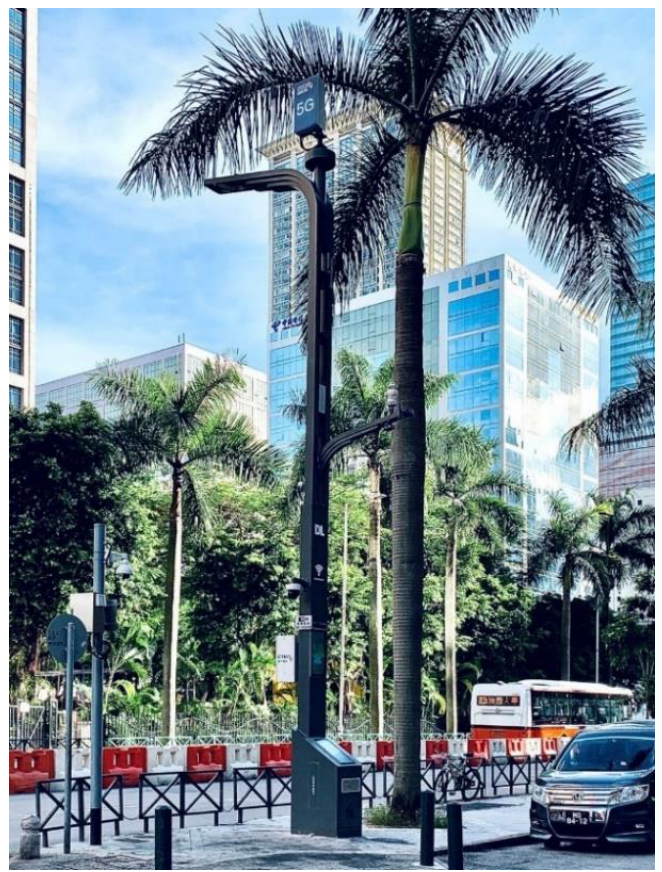
Figure 3 Smart streetlamps in Macau (Image source: Photo by the